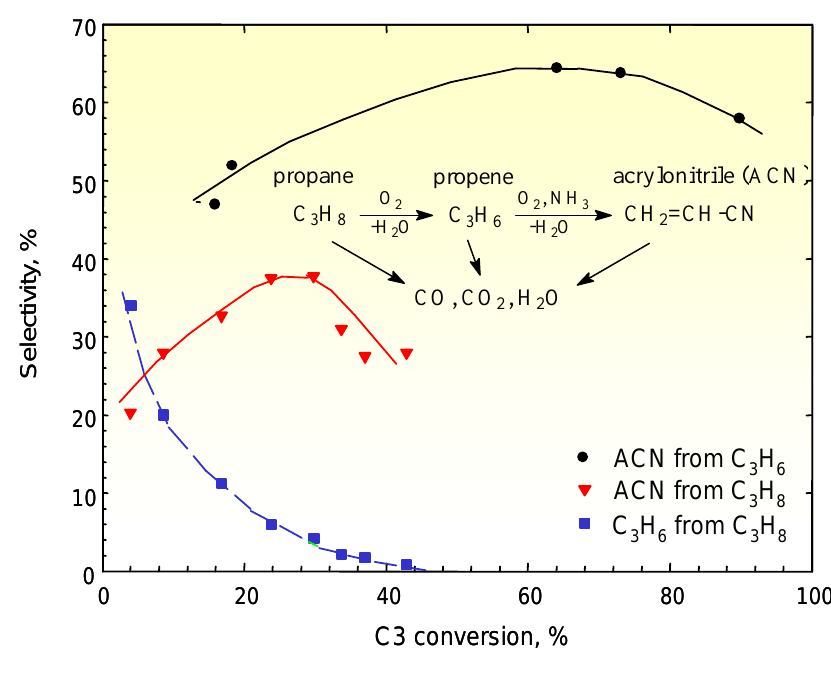
Figure 2. Comparison of the selectivity dependence on acrylonitrile in propane and propene ammoxidation at 480°C on a VSbO